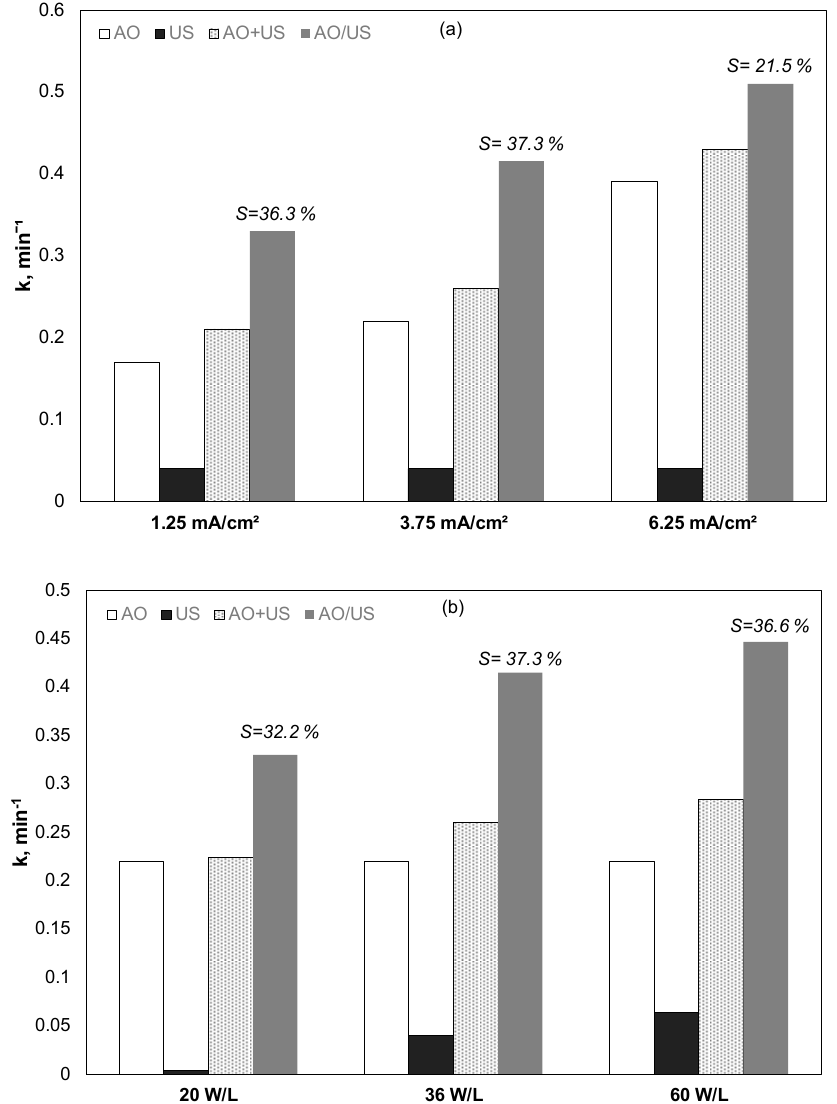
Figure 1. (Apparent) kinetic constant for the removal of 0.5 mg / L propyl paraben by anodic oxidation (AO), ultrasound (US), theoretical sum (AO + US), and combined (AO / US) process. ( a ) E ff ect of current density, US = 36 W / L; ( b ) e ff ect of ultrasound power. Conditions: [Na 2 SO 4 ] = 0.1 M, 3.75 mA / cm 2 , and inherent pH. Table 2. Summarized data from Figures 1–7. HA: Humic Acid. BIC: Bicarbonates, BW: Bottled Water, WW: Wastewater.